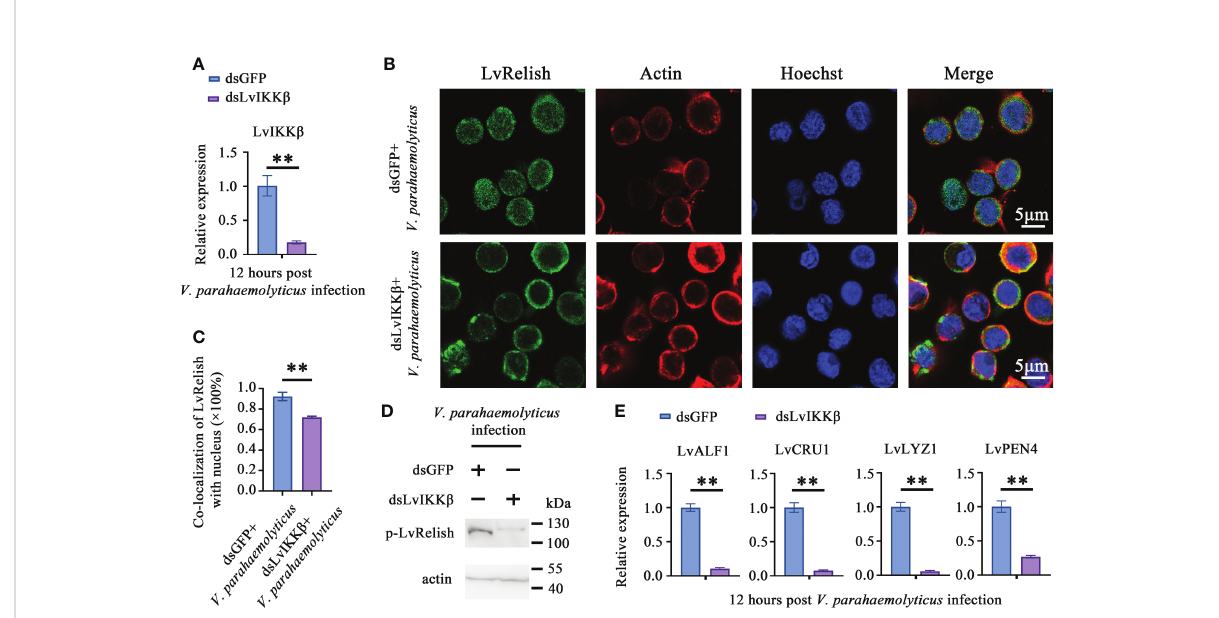
FIGURE 4 LvIKKß is required for AMPs expression and LvRelish activation. (A) RNAi ef fi ciency of dsLvIKK b in shrimp hemocytes. (B) LvRelish nuclear translocation in LvIKK b silenced hemocytes infected by V. parahaemolyticus . (C) Co-localization of LvRelish and Hochest-stained nucleus in hemocytes corresponding to Figure 4B calculated by WCIF ImageJ software. (D) The phosphorylation levels of LvRelish in the hemocytes of dsLvIKK b and dsGFP treated shrimp during V. parahaemolyticus infection. (E) The expression of AMPs in the hemocytes of dsIKK b or dsGFP treated shrimp. The data was analyzed statistically by student ’ s T test (** p < 0.01).